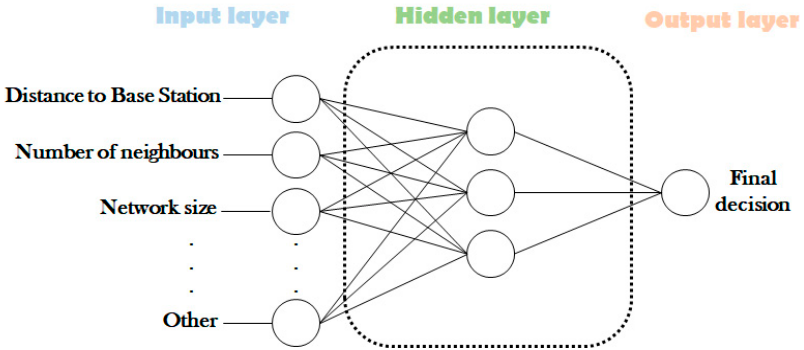
Figure 5. A simple Neural Network model.